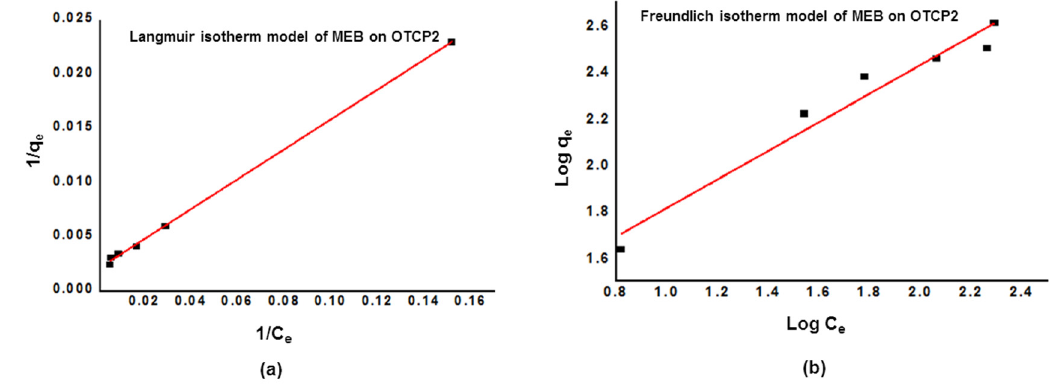
Figure 7. Langmuir isotherm ( a ) and Freundlich isotherm ( b ) models of MEB on OTCP2. Table 3. Langmuir and Freundlich isotherm model parameters for MEB adsorption on OTCP2. Langmuir Isotherm Parameters Freundlich Isotherm Parameters Dye on OTCP2 q m (mg g − 1 ) K L MEB 480.77 0.01508 0.9988 0.6136 3.3211 0.9480